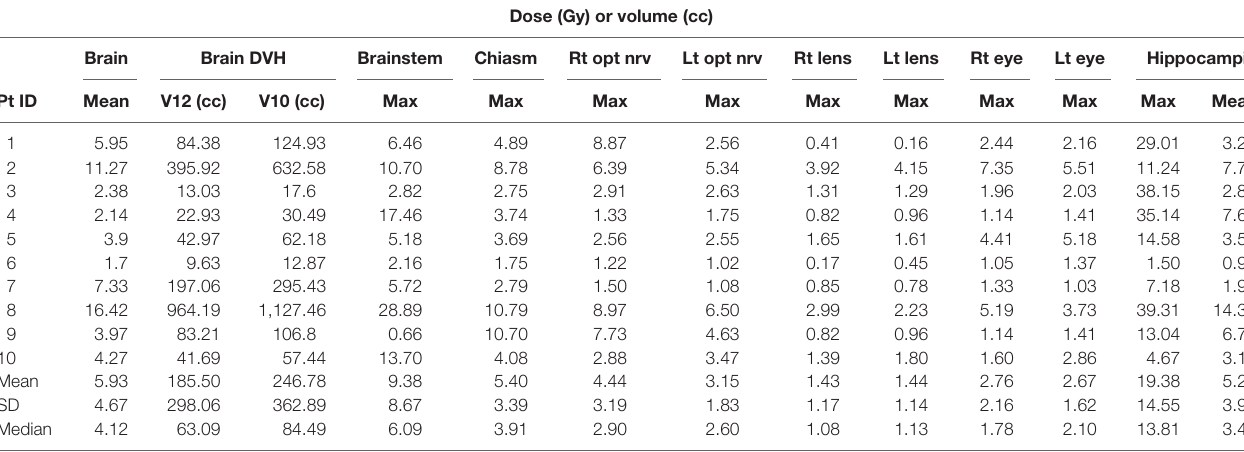
TaBle 3 | Cumulative doses to critical normal structures.